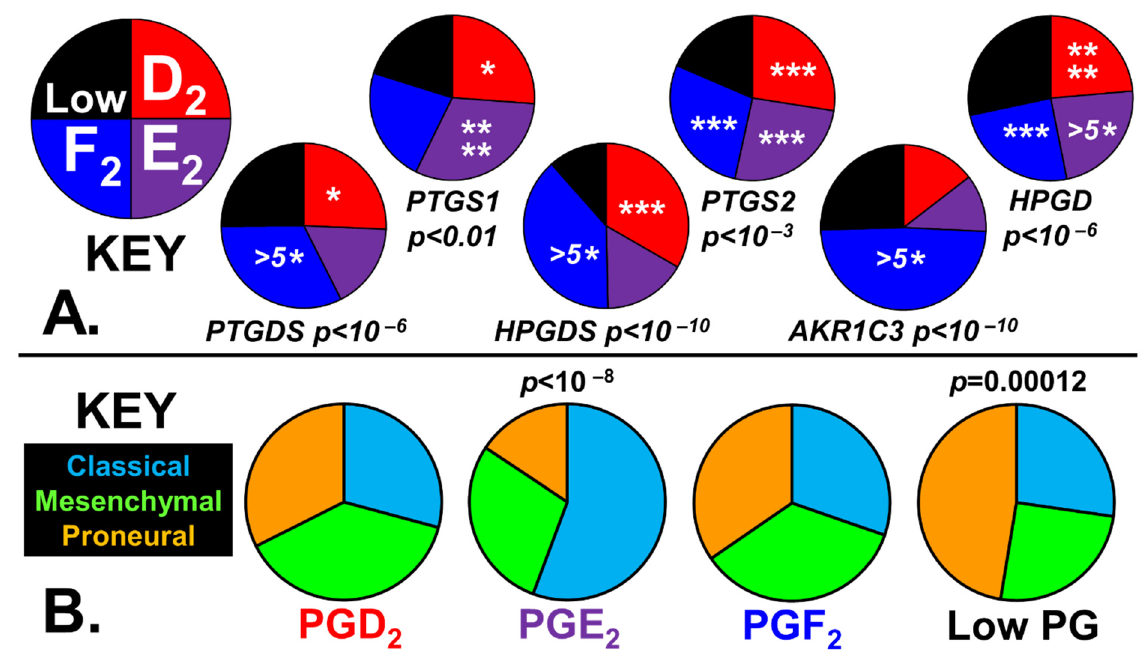
Figure 2. Phenotypes of GBM tumors are stratified into four prostaglandin-synthesizing subgroups. ( A ) The median expression levels of the enzyme transcripts used in the prostaglandin stratification are illustrated in the pie charts, and the significance derived from two different statistical tests is also indicated. The p -value calculated from the chi-squared statistic, comparing the transcript medians of the four groups with the total population, is below each chart. The stars within each slice indicate the statistical significance of transcript distributions in individual prostaglandin‑synthesizing subgroups with respect to ‘Low PG’. Statistical significance from t -tests is represented by asterisks (*), p < 0.05 *, p < 0.005 ***, p < 0.001 ****, and p < 0.0001 (5 * ) . ( B ) The fraction of the three canonical GBM subtypes within each of the PG phenotypes is represented in pie charts, with the chi-squared statistics indicated.